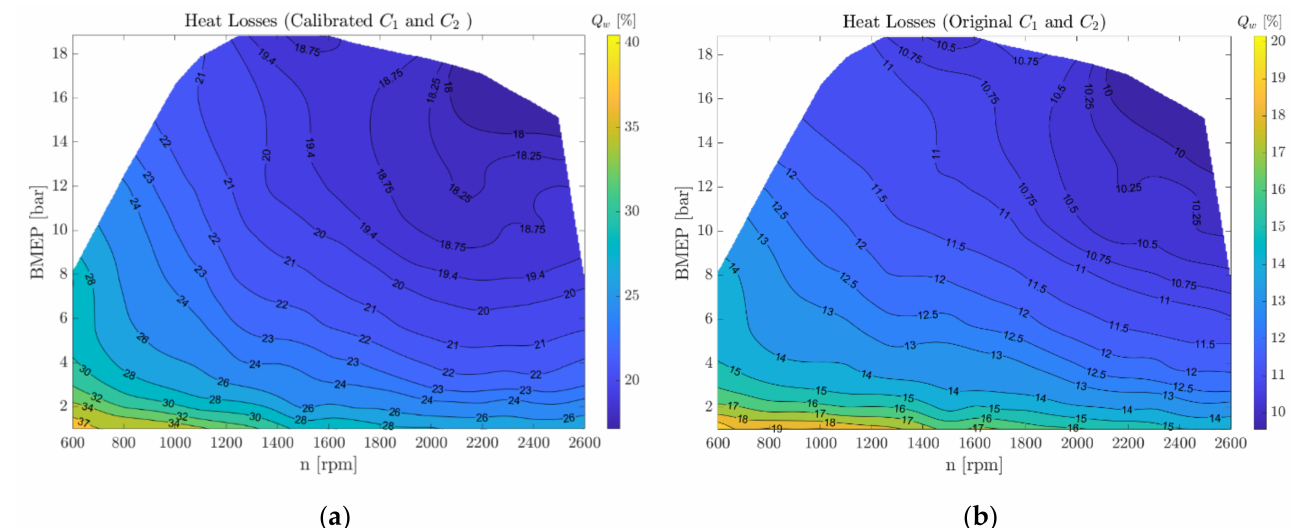
Figure 8. ( a ) Percentage heat losses with recalibrated Woschni model; ( b ) Percentage heat losses with original Woschni model (i.e., using the default coefficients of the